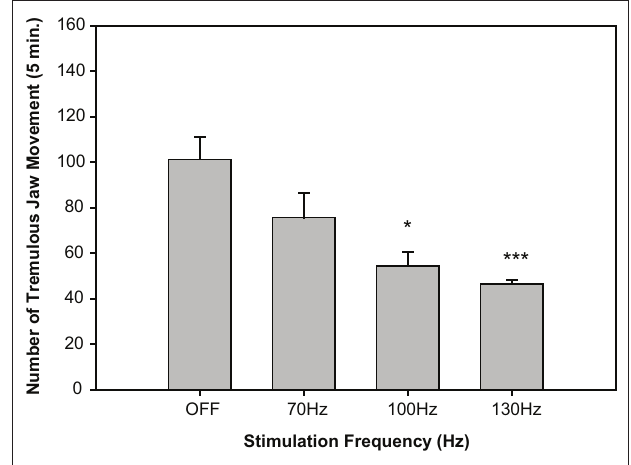
Figure 6 | effect of the adenosine A agonist CgS 21680 on the 2A induction of tremulous jaw movements. One group of rats was used; all Figure 7 | effect of subthalamic nucleus deep brain stimulation on the animals received IP injections of the following doses: saline vehicle, 0.1 mg/ tremulous jaw movements induced by 3.0 mg/kg of the kg, 0.2 mg/kg, and 0.4 mg/kg ( n = 8). Using a within-groups design, all rats anticholinesterase galantamine (iP; data are from Collins-Praino et al., received all drug treatments in a randomly varied order (one treatment per 2011a). All rats were implanted with unilateral subthalamic nucleus stimulating week). Injections were given 5 min before the animals were placed in a TJM electrodes. After injection of galantamine, rats had alternating 5-min periods of observation chamber. All animals were allowed to habituate in the chamber for stimulation off, followed by stimulation on; stimulation frequency was varied 10 min, and were subsequently observed for tremulous jaw movements for across the session. This curve shows the frequency-dependence of the effect 15 min. Data are shown as mean ( ± SEM) number of individual jaw of deep brain stimulation on tremulous jaw movements; there was an overall movements (per 15 min observation period). Systemic injections of CGS suppressive effect of brain stimulation on jaw movement activity 21680 induced tremulous jaw movements overall [ F (3,21) = 9.15, p < 0.001]. [ F (3,50) = 4.6, p < 0.01]. * p = 0.05; *** p < Planned comparisons indicated that there were significant differences between vehicle and 0.1 mg/kg CGS 21680 and 0.2 mg/kg (* p < 0.05). At the 0.4-mg/kg dose of CGS 21680, rats showed profound sedation, and were either drowsy or asleep during the observation period. (Data are from the Pharm D. honors thesis of Dr. K. L. Rychalsky, University of Connecticut).